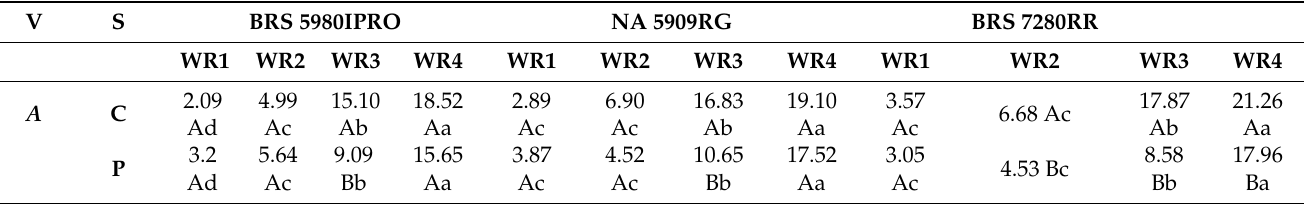
Table 2. Photosynthesis ( A ), stomatal conductance ( g s ), transpiration ( E ), maximum quantum yield of photosystem II ( F v / F m ) and effective quantum yield of photosystem II ( F v (cid:48) / F m (cid:48) ) of three cultivars of soybean, with and without added polymer to the soil in